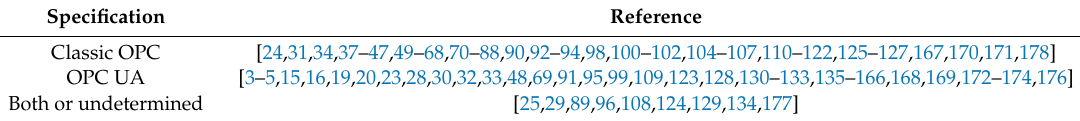
Table 8. Reviewed publications grouped according to the utilization of classic OPC, OPC UA or both.